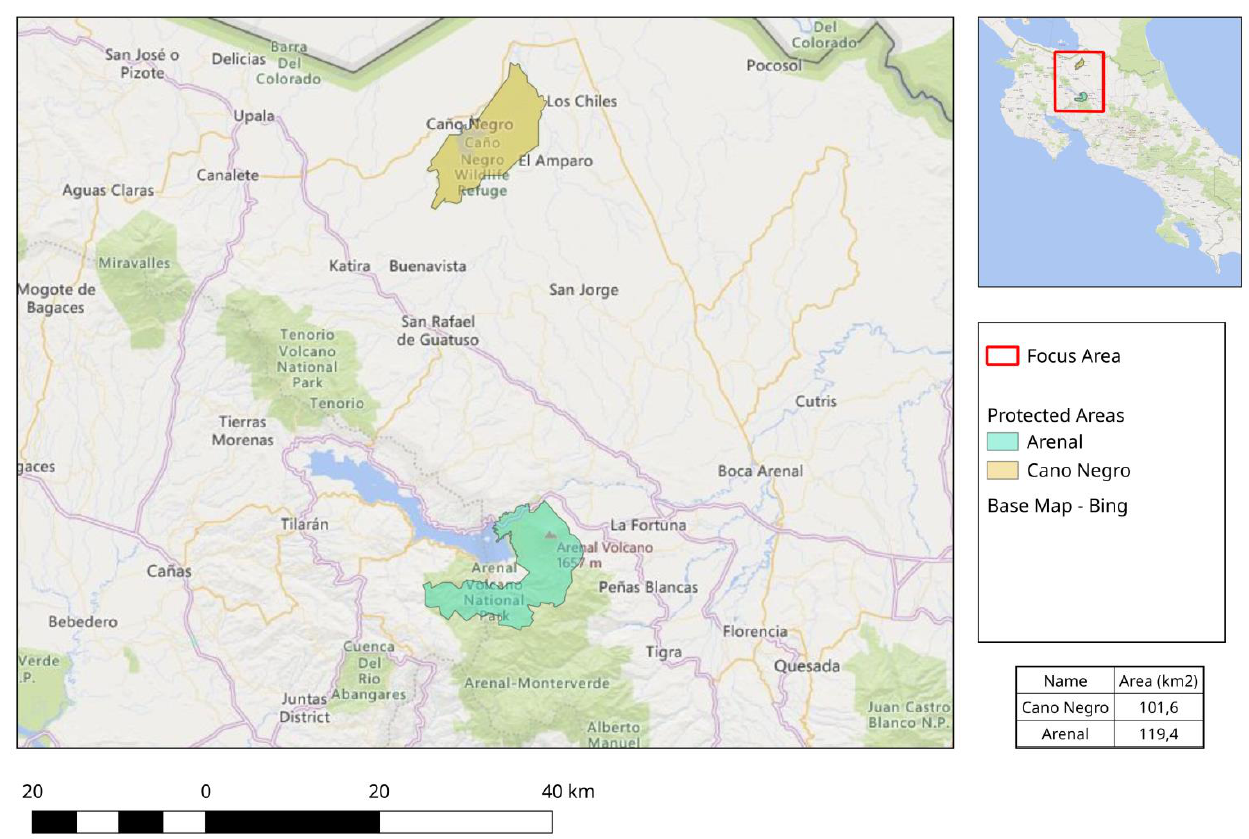
Figure 1. The geographic location of protected areas: Arenal Volcano National Park and Caño Negro Mixed National Wildlife Refuge (Costa Rica).